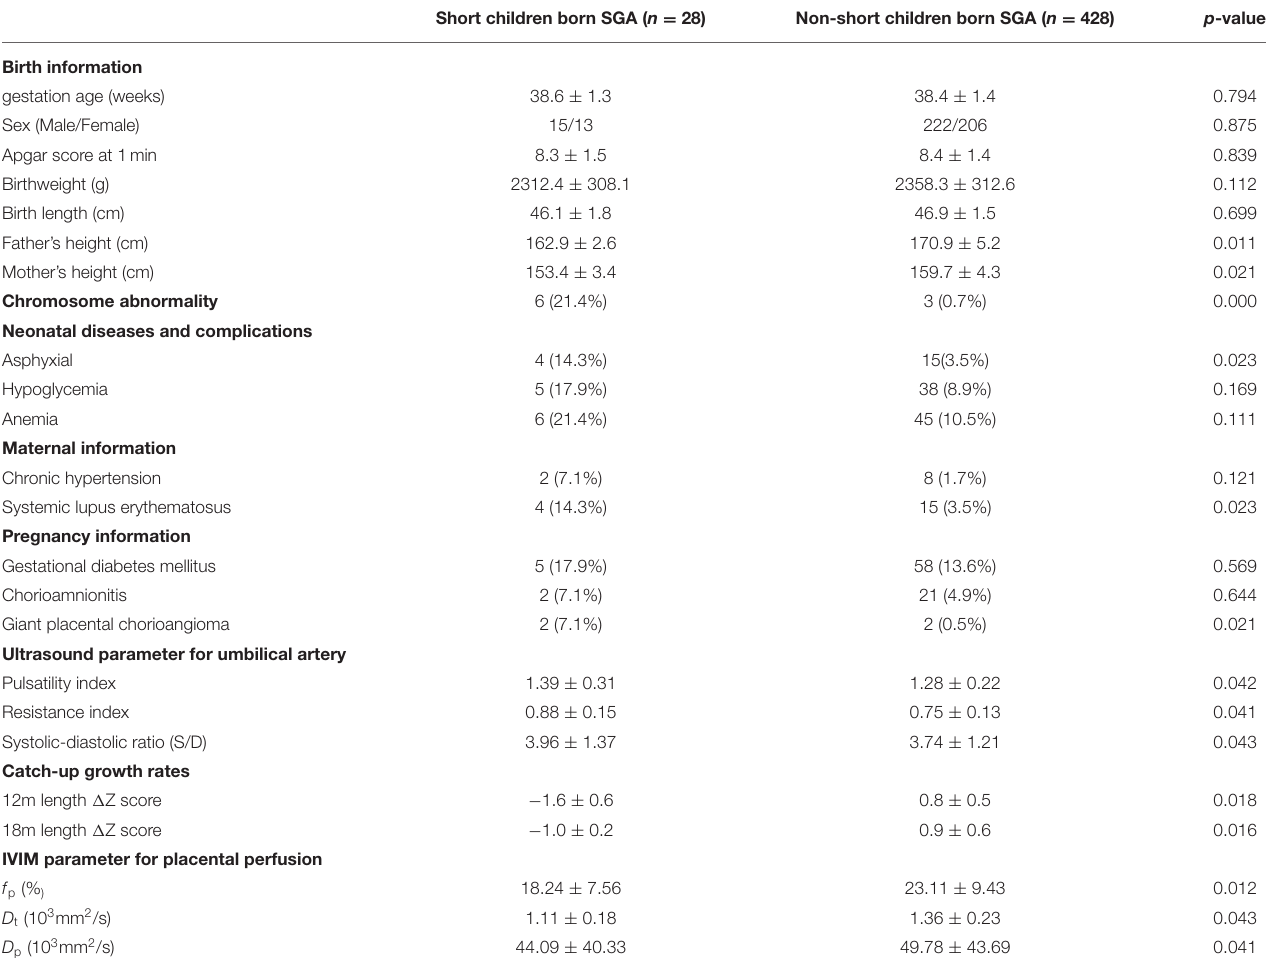
TABLE 2 | The univariate analysis of risk factors for short stature in children born SGA at full-term. Short children born SGA ( n = 28) Non-short children born SGA ( n =